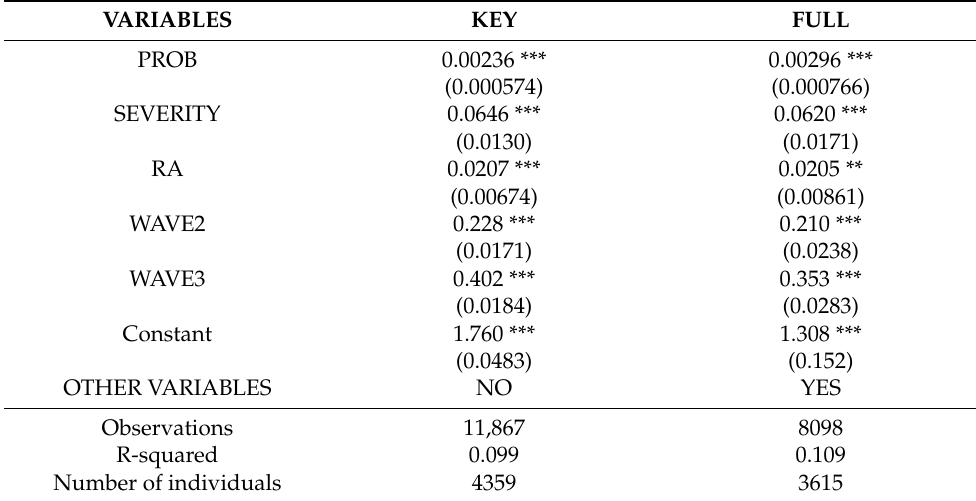
Table 5. Estimates of Equation (1) with the fixed effect model